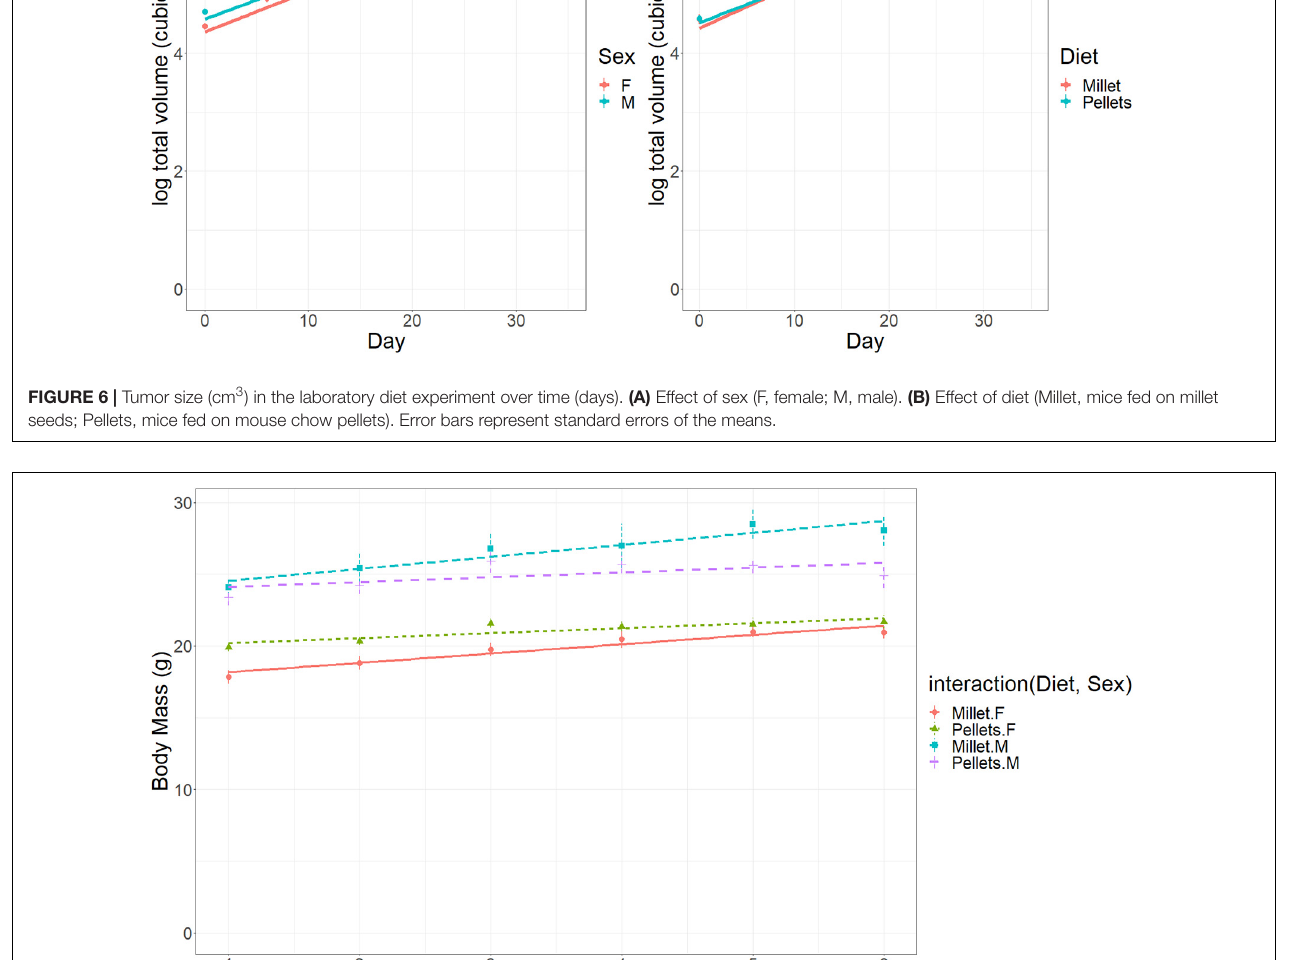
At the end of the experiment there was some to no correlation across mice between the tumors on the right and left flanks [Pearson’s correlation of 0.526 and − 0.017 for the first ( n = 34) and second ( n = 24) experiments,